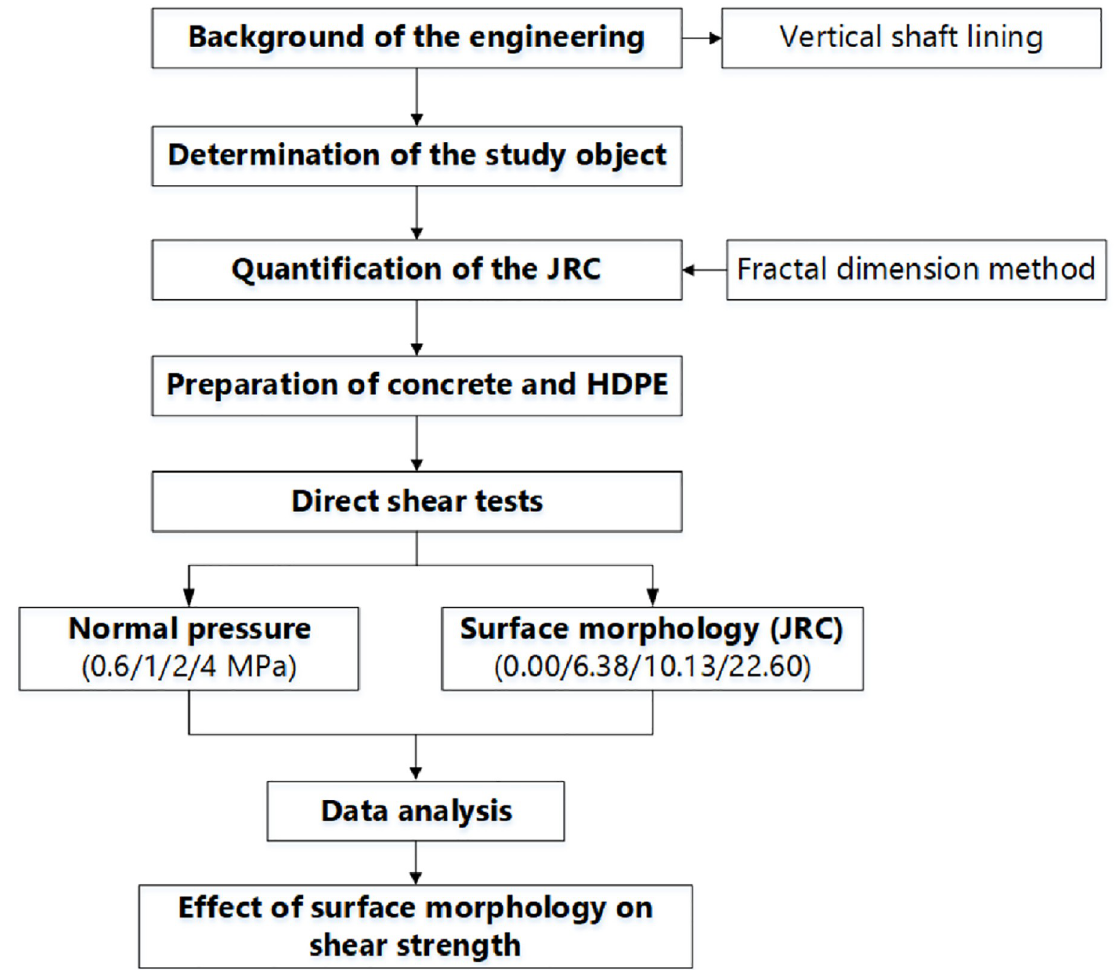
Fig 3. Flow chart of the